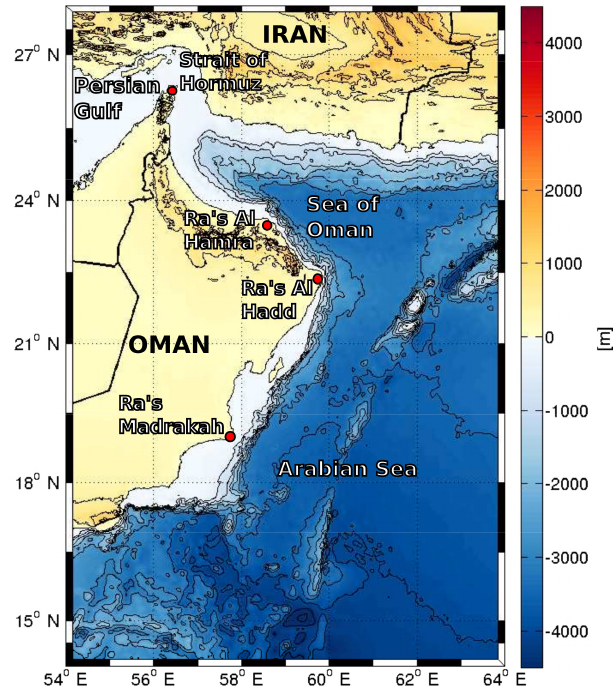
Figure 1. Topographic map of the Arabian Sea and Sea of Oman with the locations of